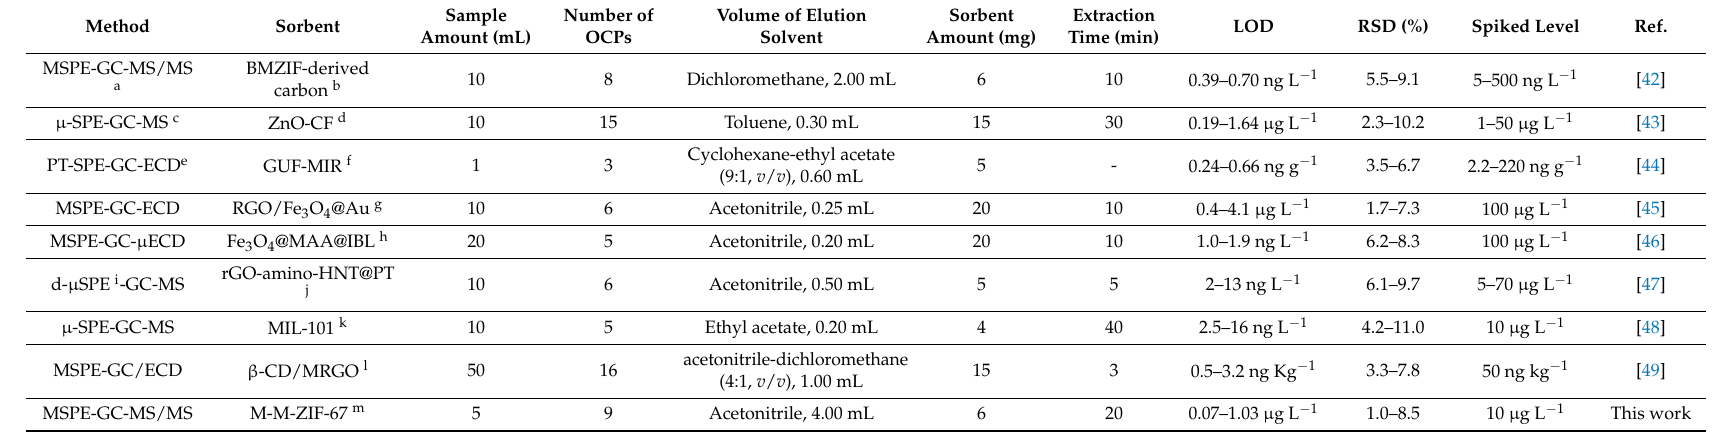
Table 3. Comparison of different methods for analysis of organochlorine